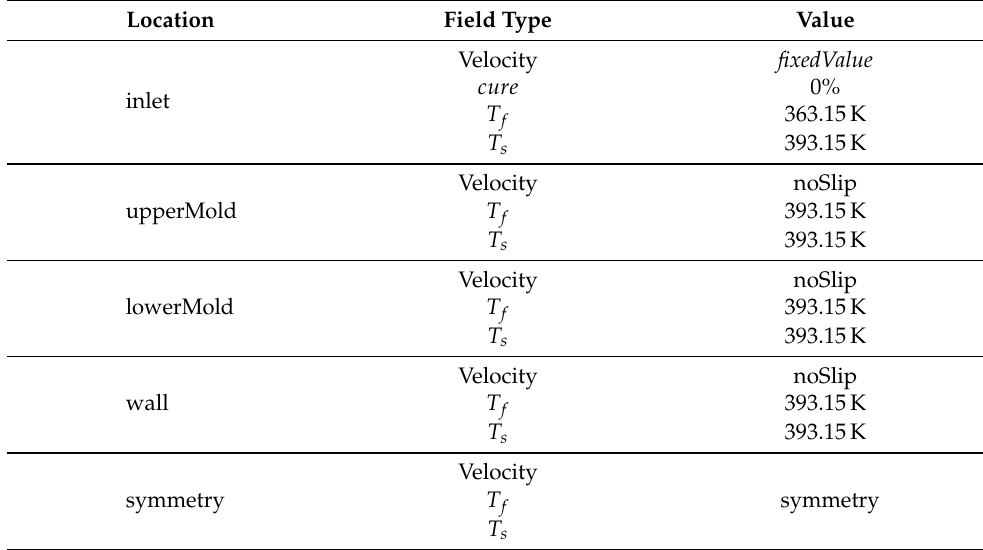
Table 1. Boundary conditions used for non-dimensional analysis